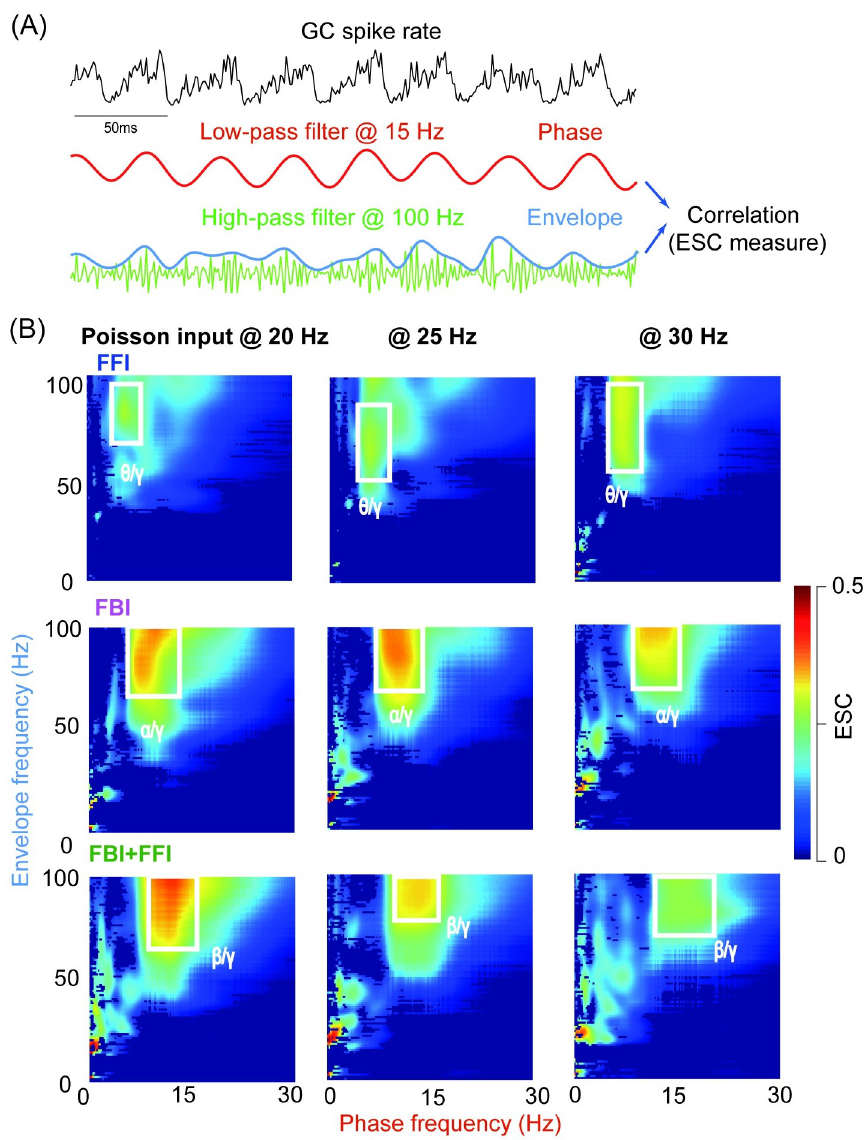
Fig 5. Cross-frequency coupling of network oscillations induced by gap junction. (A) Schematic view of phase- amplitude coupling. The raw signal of GC population spike rate with 25 Hz Poisson MF inputs in the FFI+FBI network. The low-pass filtered signal (middle, filtered at 15 Hz) for phase information. The high-pass filtered (bottom, filtered at 100 Hz) signal for amplitude envelope. The strength of phase-amplitude coupling was quantified as the envelope-signal coupling (ESC) correlation. (B) The ESC measure as a function of frequencies of phase (low-pass filter) and envelope (high-pass filter) computed for GC oscillations with Poisson inputs at 20, 25, and 30 Hz under three scenarios: FFI (top), FBI (middle), and FFI+FBI